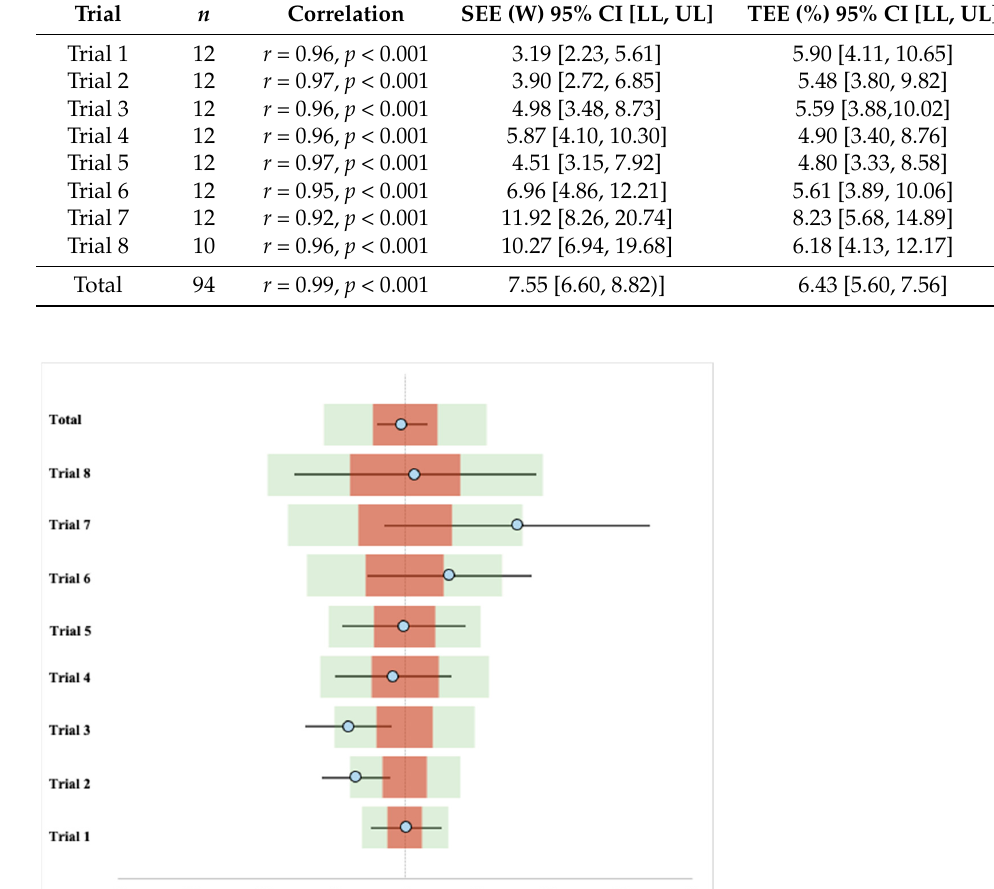
Table 2. Correlation and linear regression results by trial 1-minute average power.